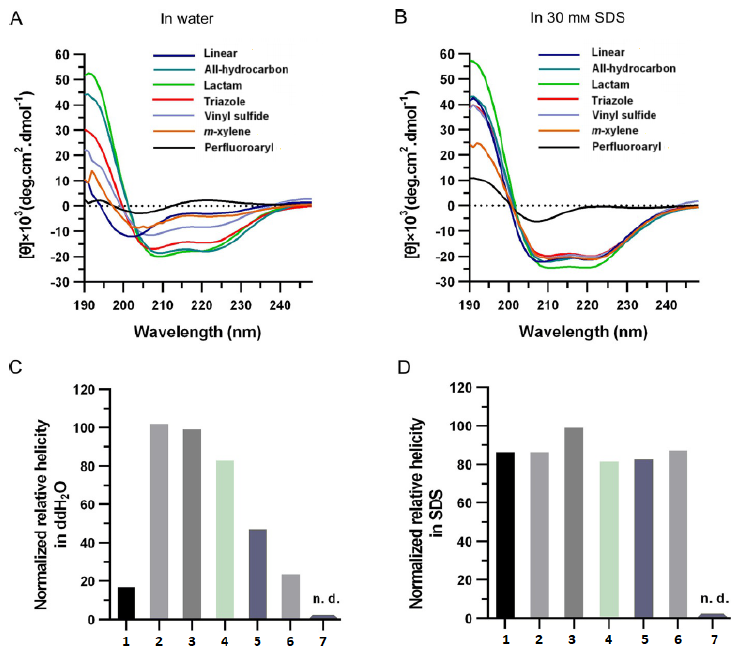
Figure 7. Circular dichroism spectra of peptides measured in ddH 2 O ( A ) and in 30 mM SDS solution ( B ). Schematic comparison of the relative helical contents in ddH 2 O ( C ) and 30 mM SDS solution ( D ) ( 1 = unstapled; 2 = all-hydrocarbon-; 3 = lactam-; 4 = triazole-; 5 = vinyl sulfide-; 6 = xylene-; 7 = perfluoroaryl-)). The relative helicity was normalized with respect to the peptide with a lactam crosslink. n.d.: not determined as a result of additional absorption